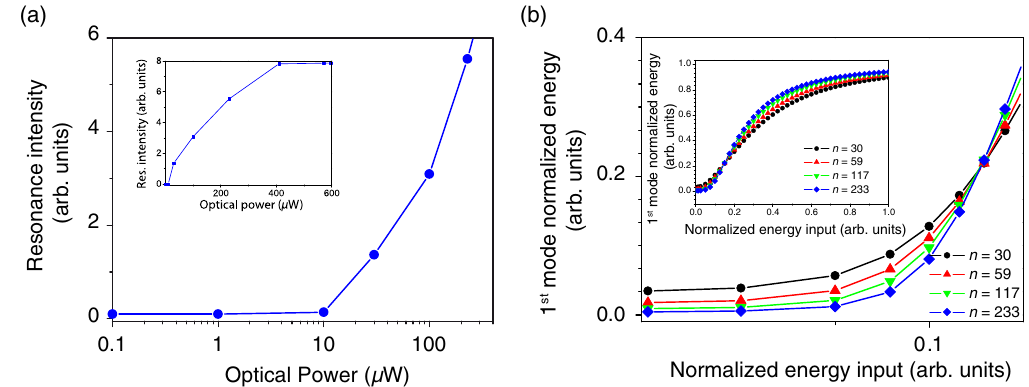
FIG. 5. Thresholdlike behavior of giant dipolar oscillations. (a) Intensity of the resonant peak measured at 0.314 THz as a function of the optical laser power. (b) Normalized energy of the fundamental mode calculated as a function of the normalized source power. The different curves correspond to the reported numbers of normal modes of the BSA protein. Theory and experiment are in qualitative